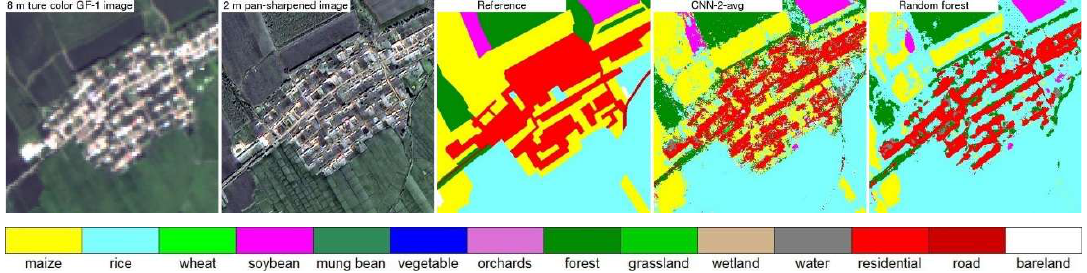
Figure 8. Same as Figure 7 but for the example 400 × 400 pixels in the box area in study area 2 (Figure 3).